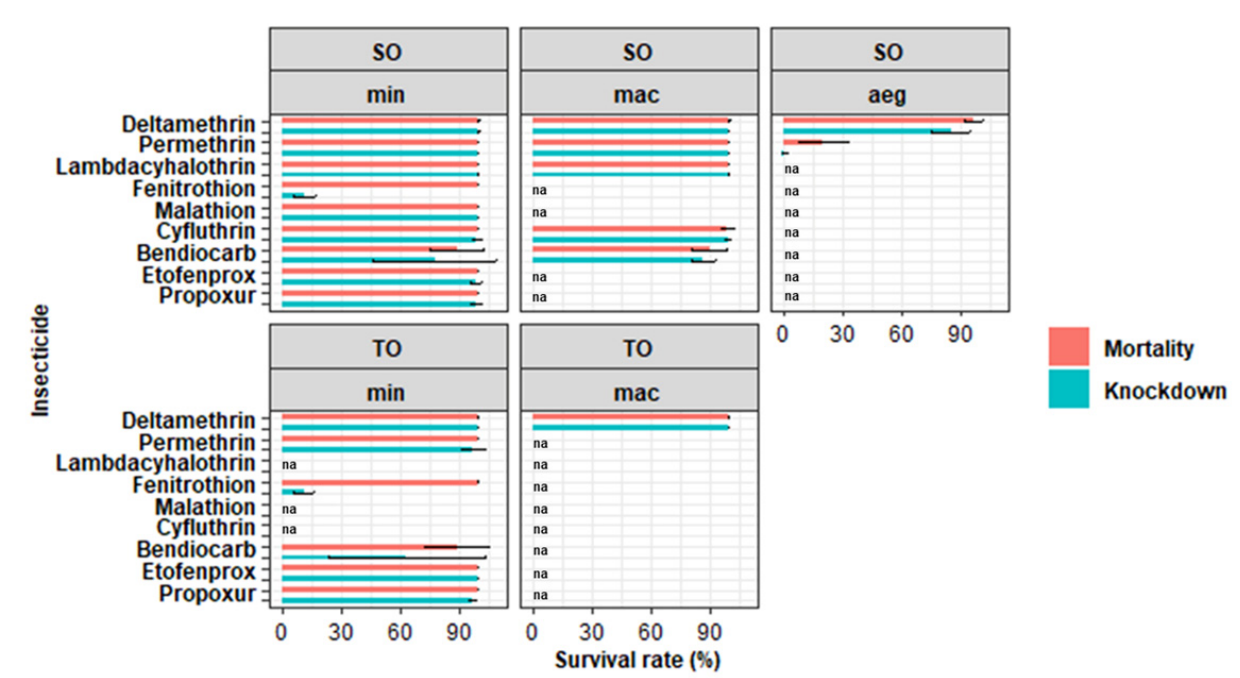
Figure 2. Mortality and knockdown rate assessed following the WHO guidelines for insecticide monitoring in An. minimus s.l. (min), An. maculatus s.l. (mac), and Ae. aegypti (aeg) from Suan Oi (SO) and Tala Oka (TO) villages. Error bars represent standard error; na represents no data